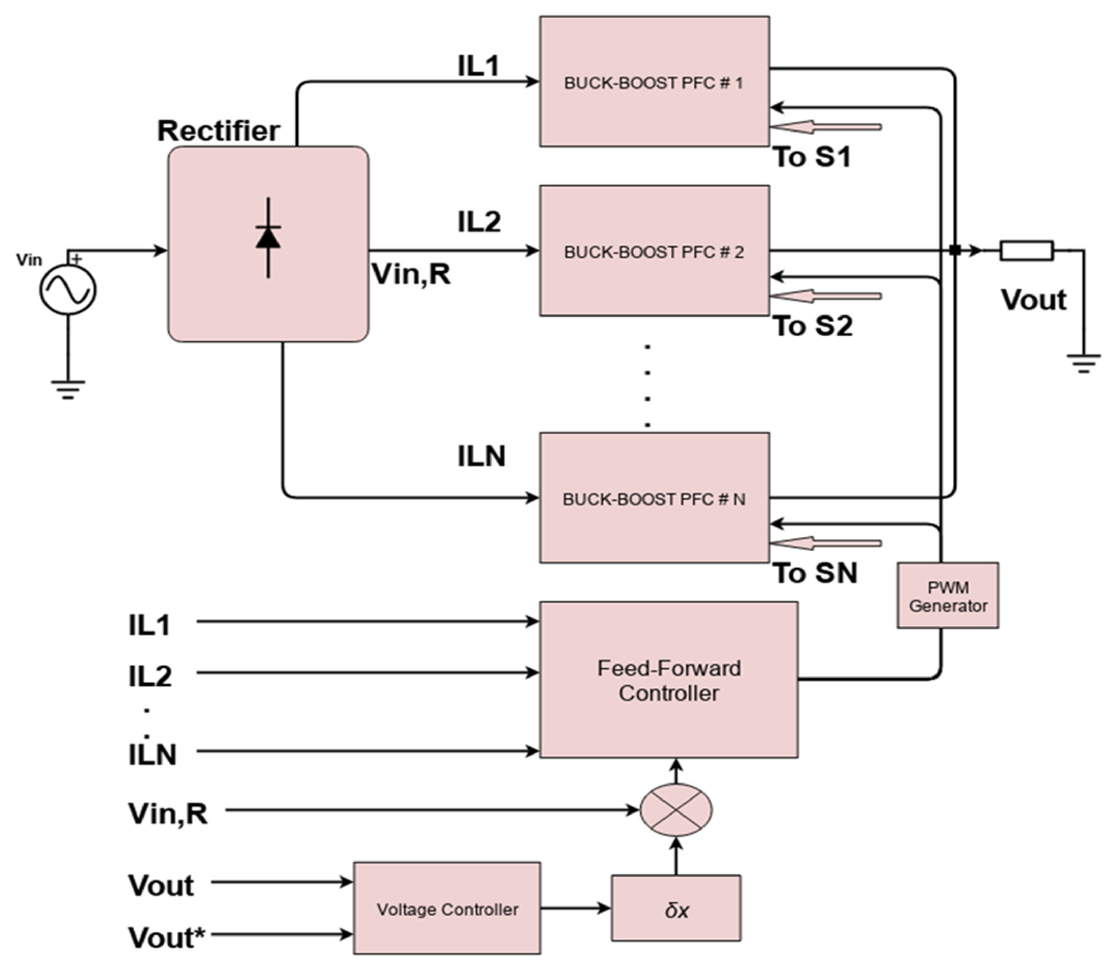
Figure 6. N ‐ parallel ‐ connected buck ‐ boost PFC with feed ‐ forward control implementation. Figure 6. N-parallel-connected buck-boost PFC with feed-forward control